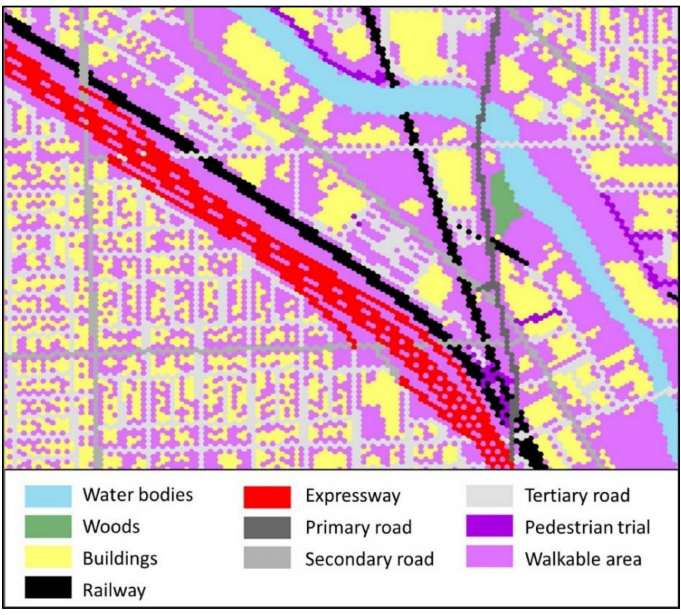
Figure 3. Hexagonal accessibility-weighted plane for private transport